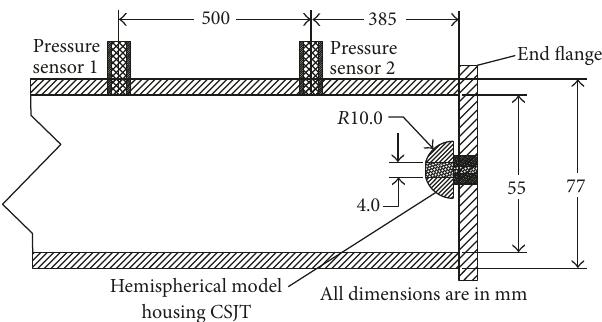
Figure 13: Schematic of the end-section of the shock tube showing the mounting of coaxial thermocouple on the hemispherical model at the end flange.